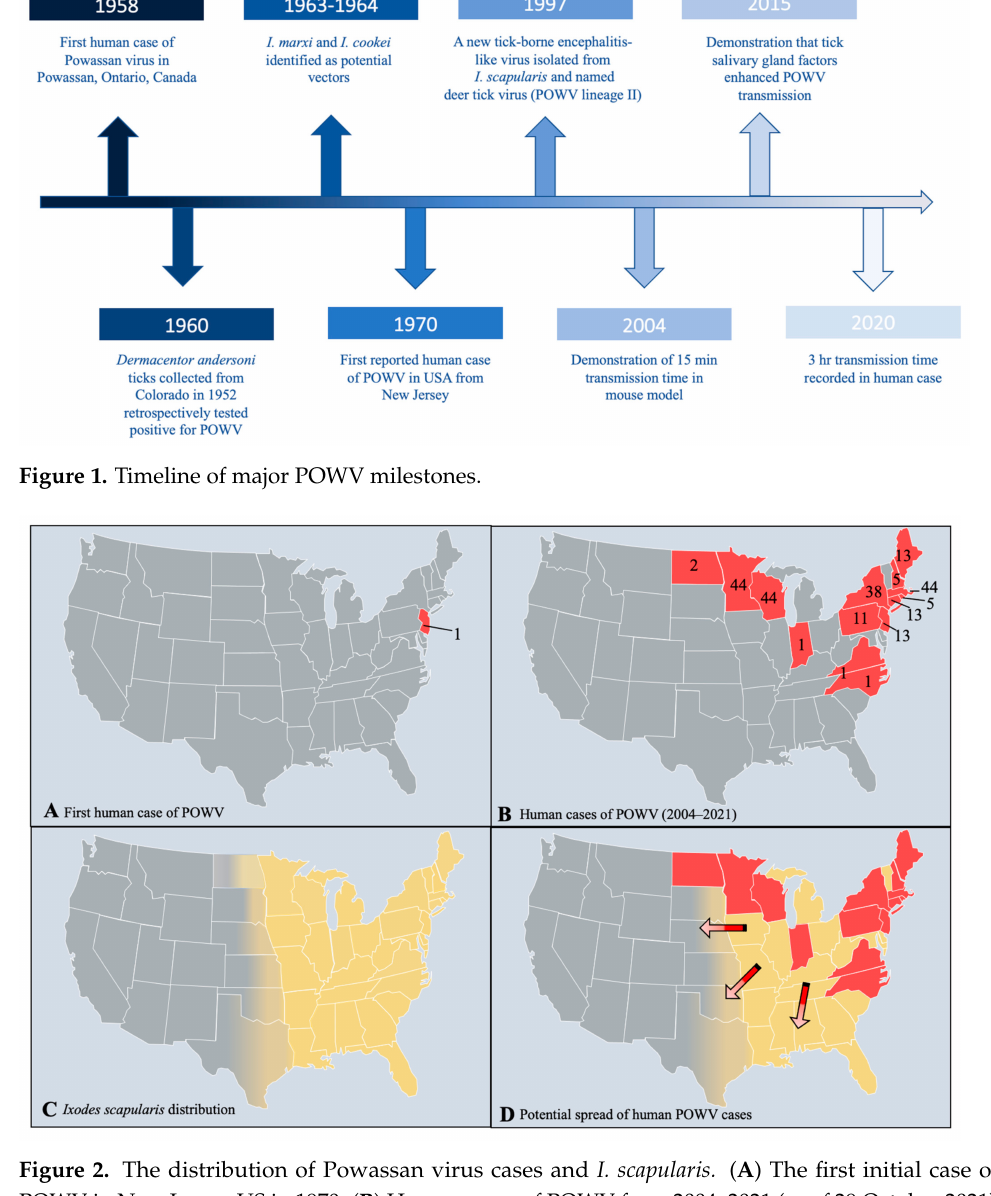
Figure 2. The distribution of Powassan virus cases and I. scapularis. ( A ) The first initial case of POWV in New Jersey, US in 1970. ( B ) Human cases of POWV from 2004–2021 (as of 29 October 2021), reported by the CDC and ArboNet. ( C ) The distribution of I. scapularis based on data from the CDC. ( D ) The potential range expansion of POWV cases based on the distribution of I. scapularis. Red states indicate current POWV presence, yellow states designate I. scapularis distribution, and arrows show the potential direction of spread for